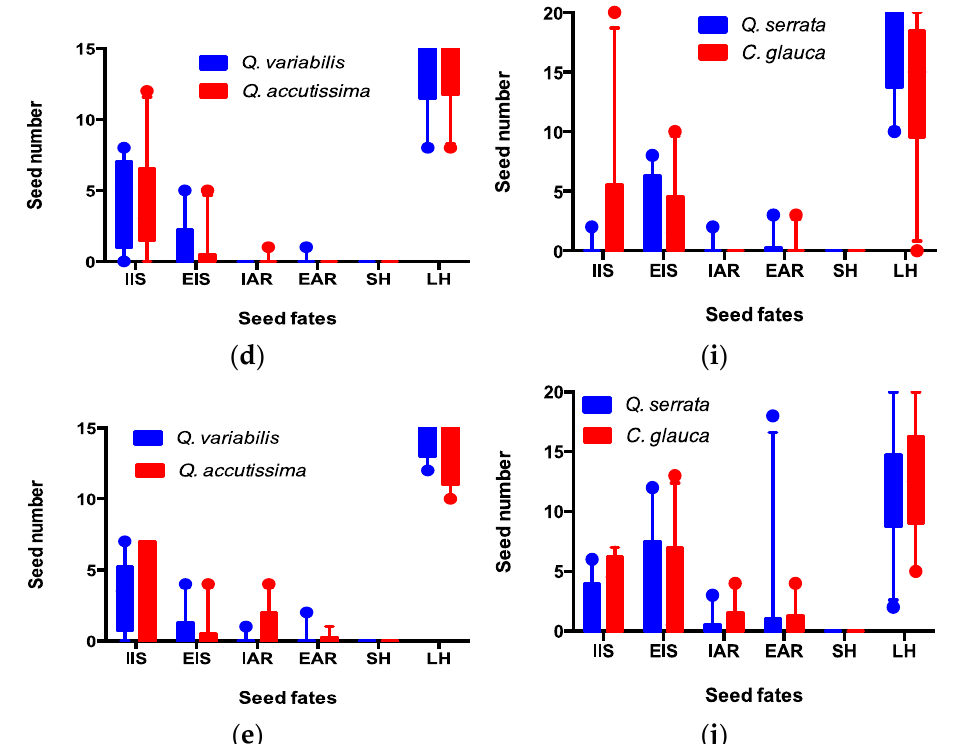
Figure 5. Seed fates of Q. variabilis and Q. accutissima ( a – e ), as well as Q. serrata and C. glauca ( f – j ) manipulated by Leopoldamys edwardsi , Apodemus draco , A. chevrieri , Niviventer confucianus , and N. fulvescens , respectively. IIS, EIS, IAR, EAR, SH, and LH indicate acorns intact in situ, eaten in situ, intact after removal, eaten after removal, scatter-hoarded, and larder-hoarded, respectively.